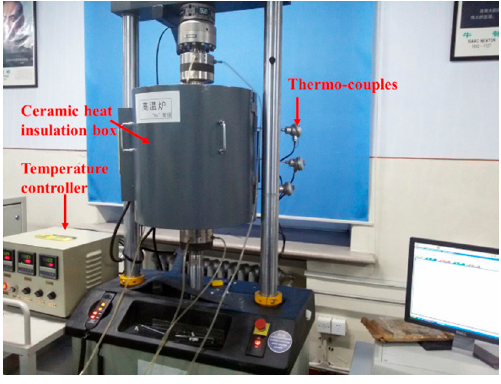
Figure 3. Experimental set-up.